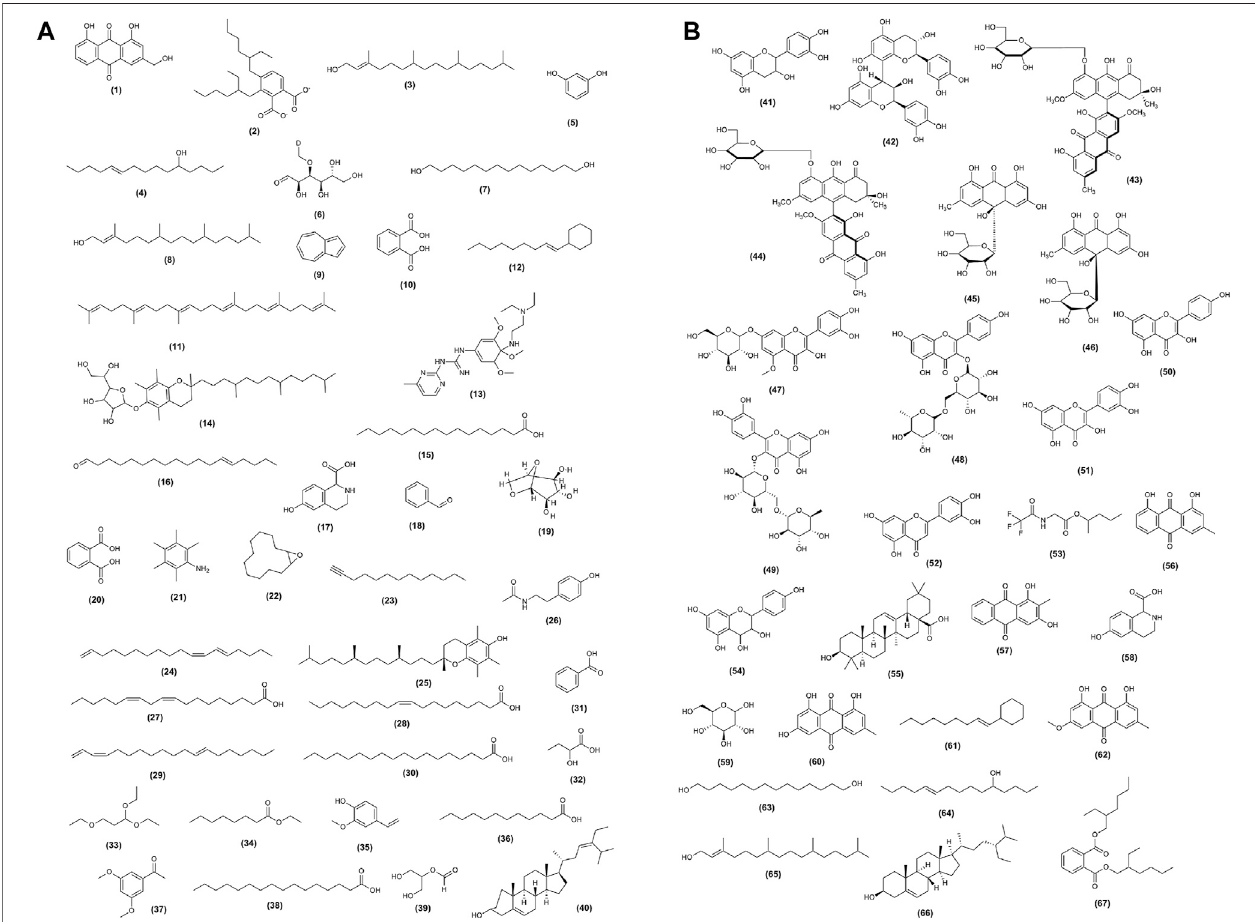
FIGURE 3 | (A) Structure of metabolites of Senna auriculata (L.) Roxb. (B) Structure of metabolites of Senna auriculata (L.)